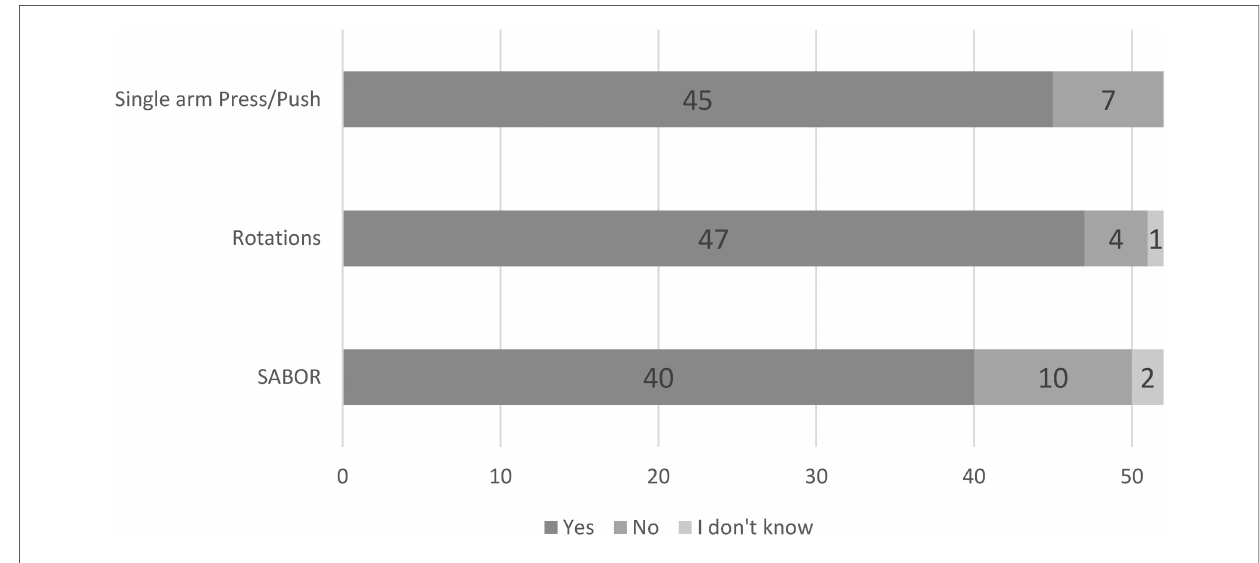
FIGURE 4 The use of upper body fl ywheel exercises amongst therapists working in sport. N =52.